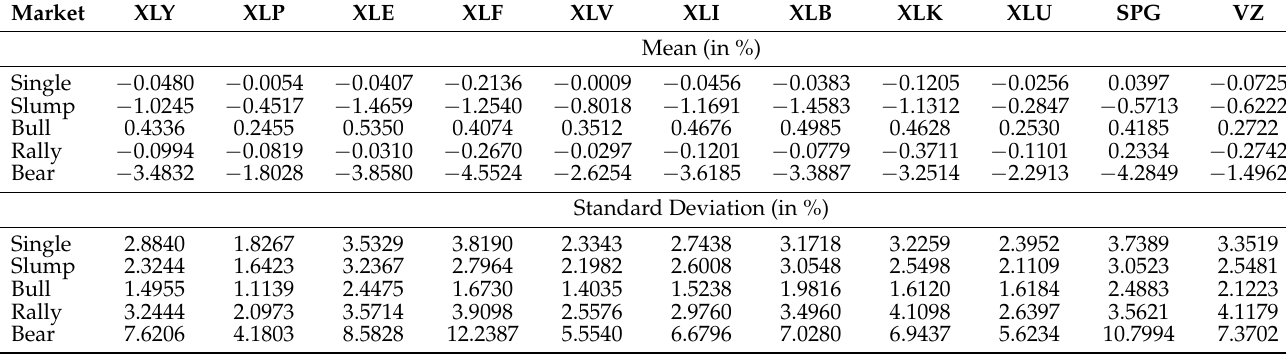
Table 5. Conditional means and standard deviations of security